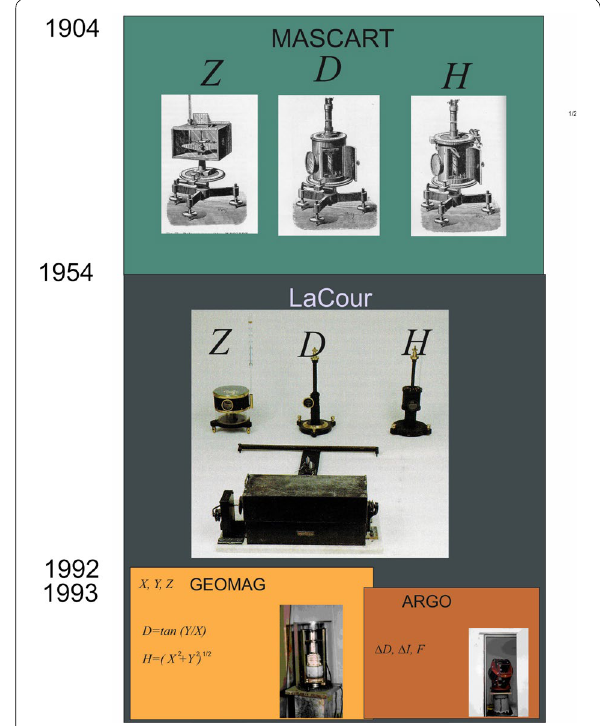
Fig. 10 Chronogram of the main variometers used at Ebro Observatory during the twentieth